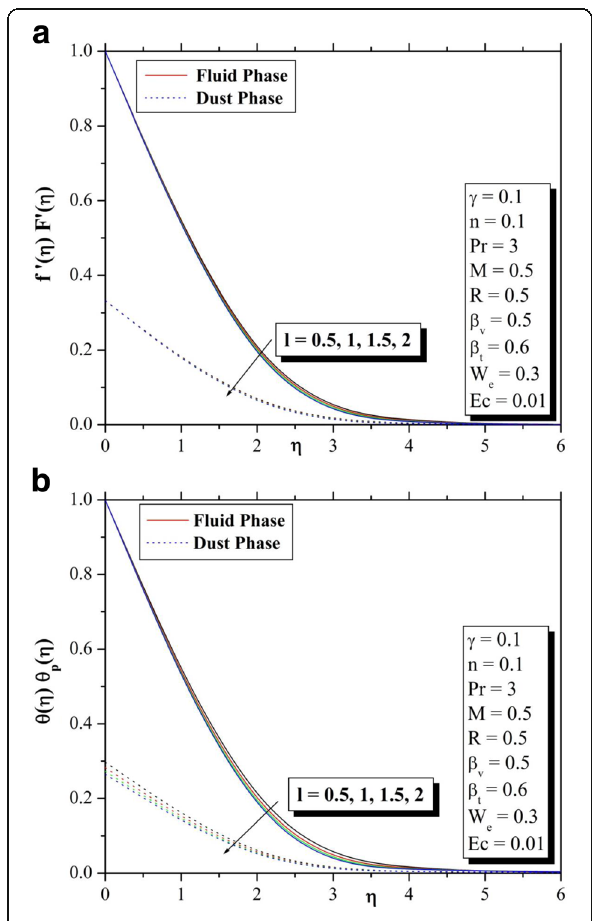
Fig. 6 a , b Velocity profile and temperature profile for different values of l